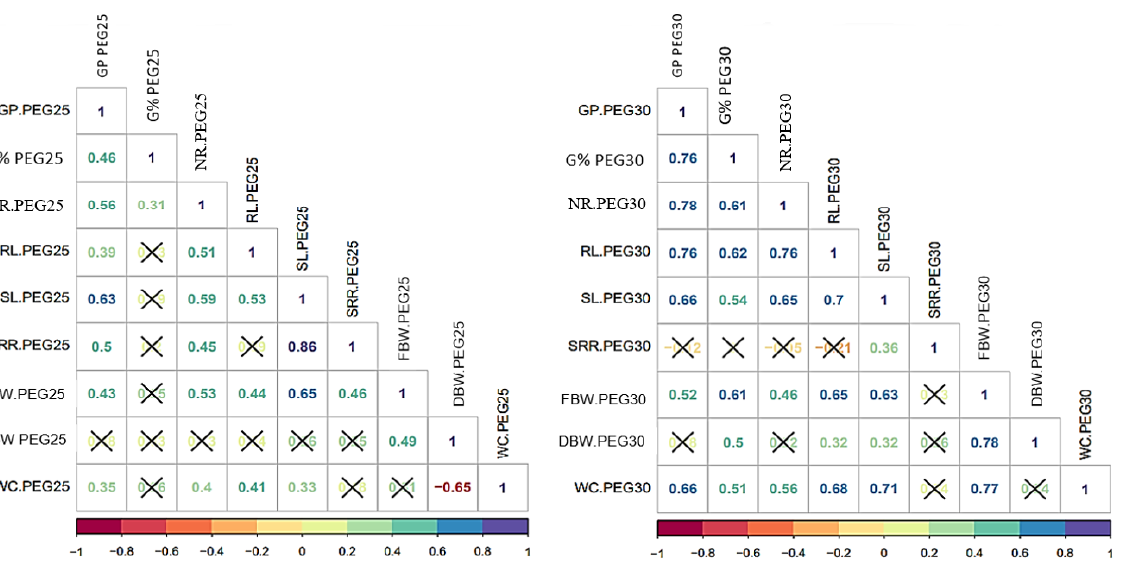
Figure 1. Mean values for germination and seedling growth parameters under PEG-6000 concentrations (PEG25%, PEG30%) among 41 spring wheat genotypes; Germination percentage (G%); Germination pace (GP); Water content (WC); Number of root (NR); Root length (RL); Shoot length (SL); Shoot-root length ratio (SRR); Fresh biomass weight (FBW); Dry biomass weight (DBW).